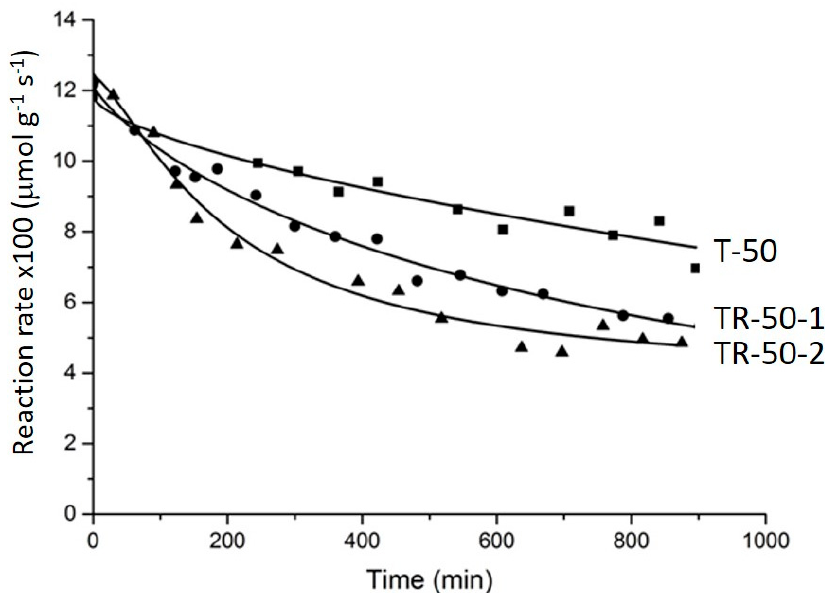
Figure 5. Temperature programmed oxidation of spent catalysts with a mixture of 20 vol.% O 2 in He. Heating rate: 5 K min − 1 .